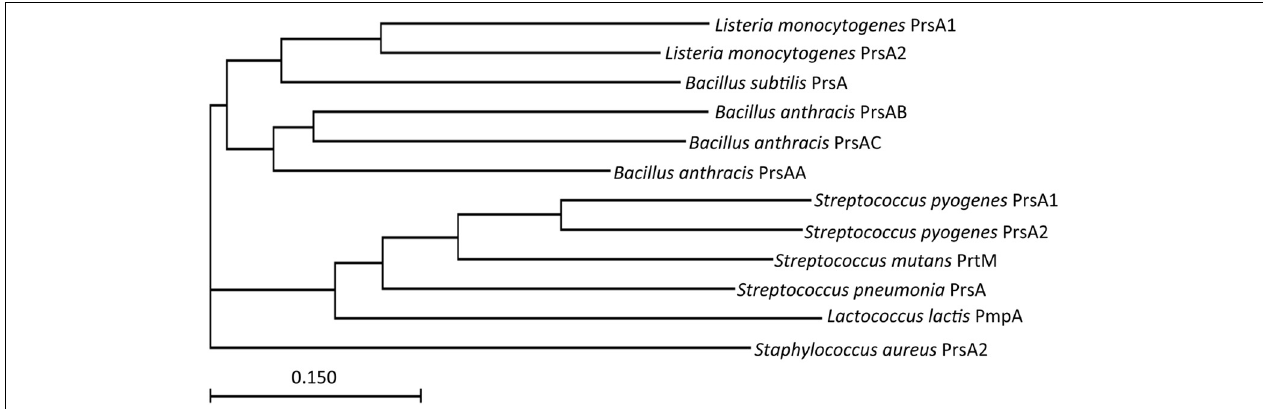
FIGURE 1 | The evolutionary relationship of PrsA homologs from Gram positive bacteria. Shown is a phylogenetic tree of PrsA homologs from Listeria monocytogenes and other Gram positive bacteria created by CLUSTAL analysis. The scale bar indicates 1 substitution for every 10 nucleic acid residues.